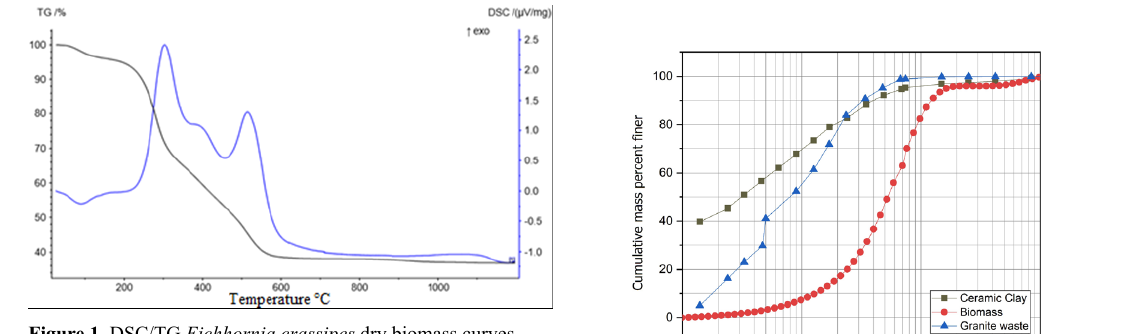
Figure 1. DSC/TG Eichhornia crassipes dry biomass curves.